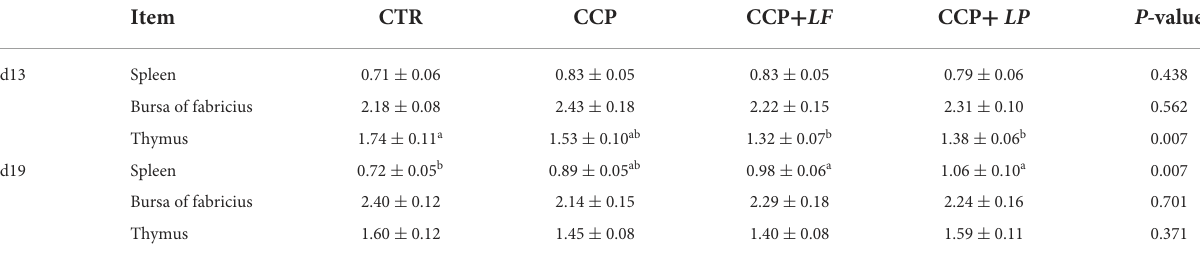
TABLE 4 The immune organ indices, g/kg, n =